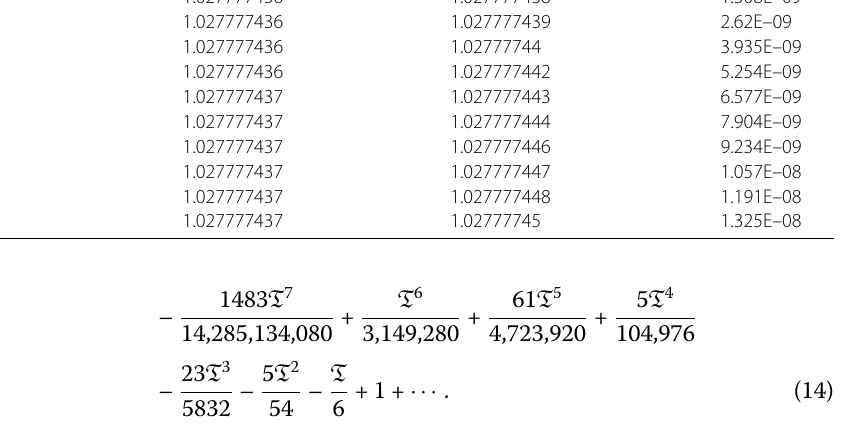
Table 4 Numerical values of the solutions through the ECBS method Value of T Analytical Approximate Absolute error